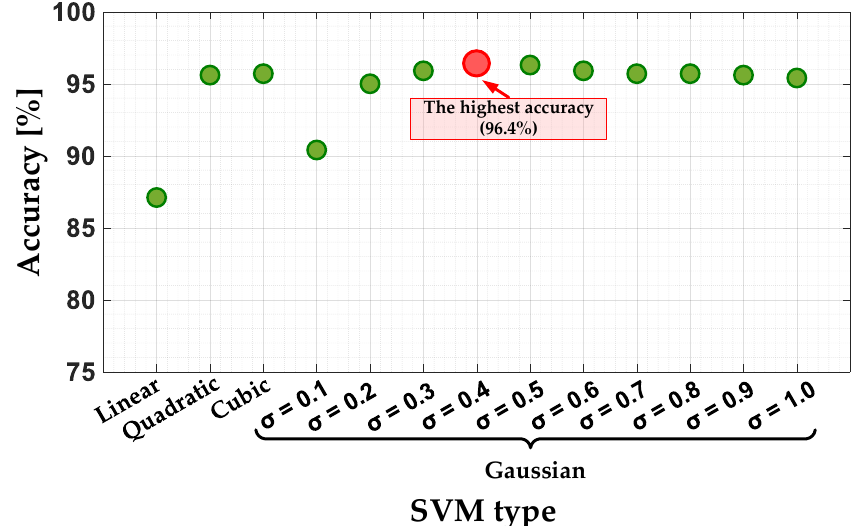
Figure 16. The impact of the SVM type on the SVM classifier accuracy. Table 1. The SVM classifier accuracy for different kernel function. Kernel Function